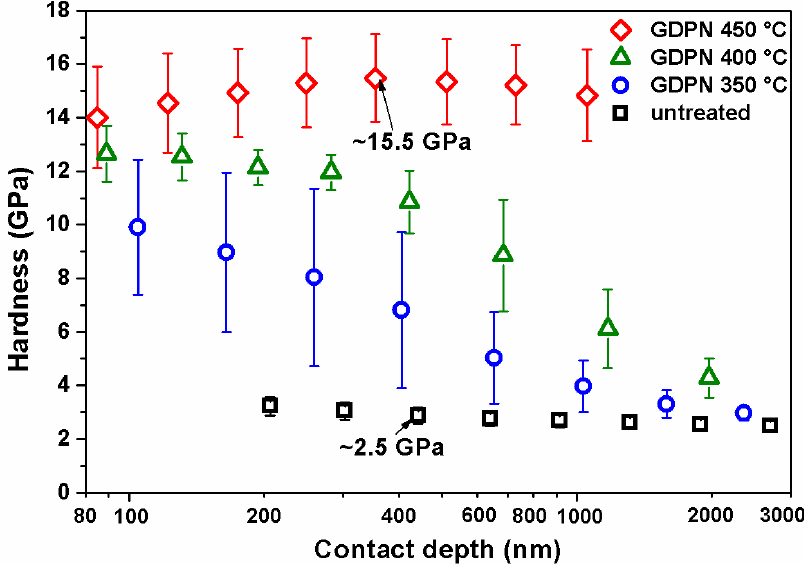
Figure 11. Hardness profiles of untreated and GDPN-nitrided samples.